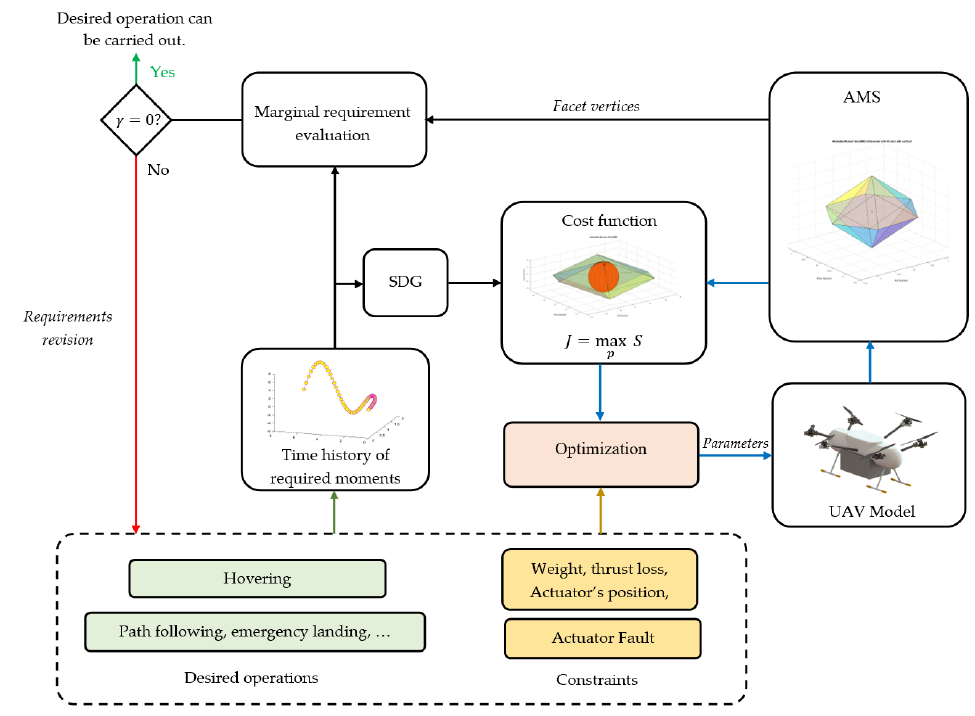
Figure 3. Optimization framework.